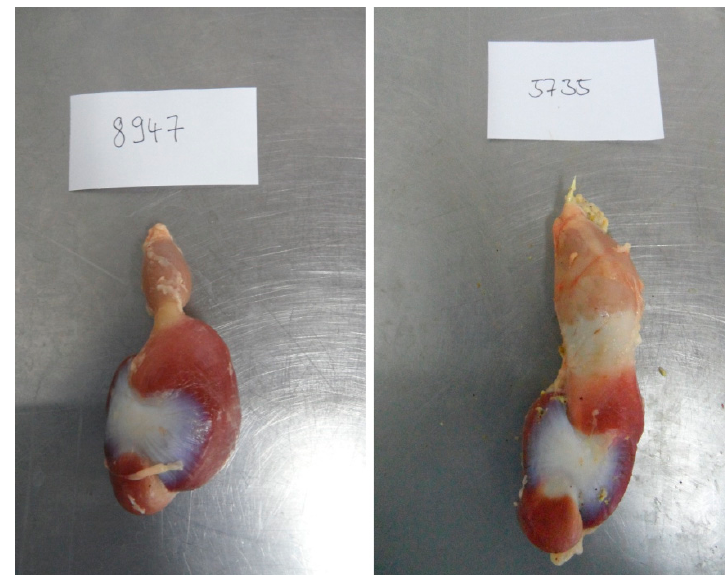
Figure 1. Example for assessment of the Isthmus gastrici (ISC), left : ISC = 0 (example animal fed coarsely ground non-compacted feed); right : ISC = 3 (example animal fed finely ground and pelleted feed) .